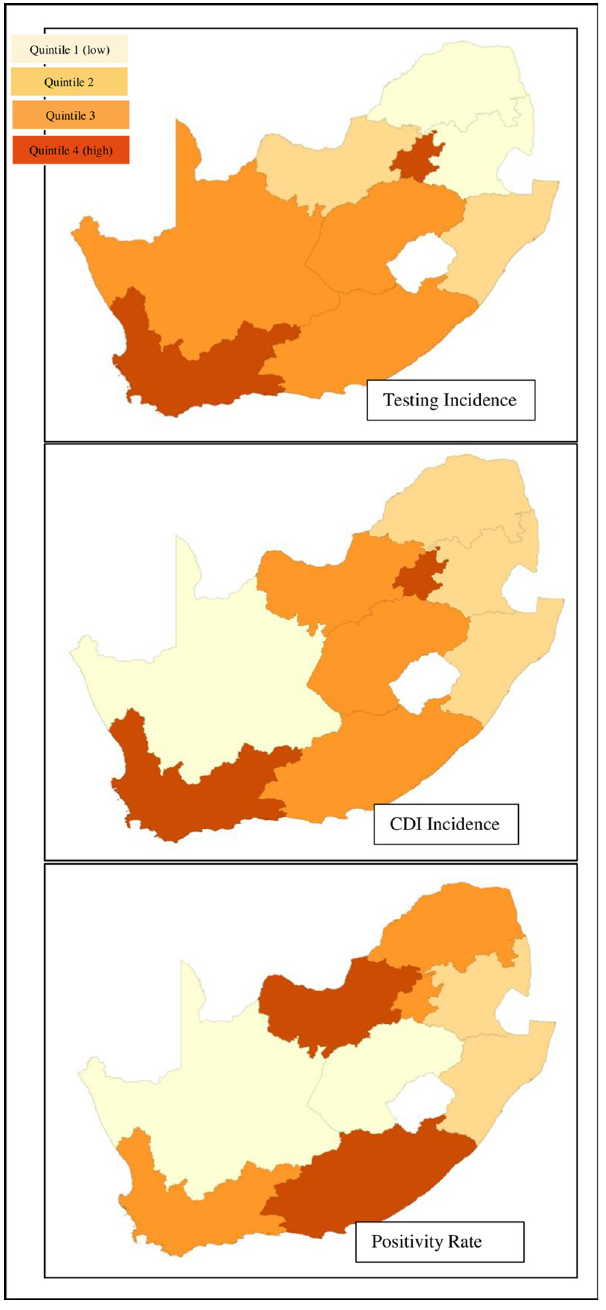
Fig 3. Provincial clostridioides difficile testing, CDI incidence and positivity rates by quintile: Incidence varied widely across provinces with Gauteng’s incidence of CDI estimated at 158.45 per 100 000 admissions followed by the Western Cape at 107.52. In contrast the Northern Cape recorded no CDI cases and for Limpopo province, we estimated an incidence of 0.81 cases per 100 000 admissions. There was less variation in the positivity rate across provinces. The national average positivity rate was estimated at